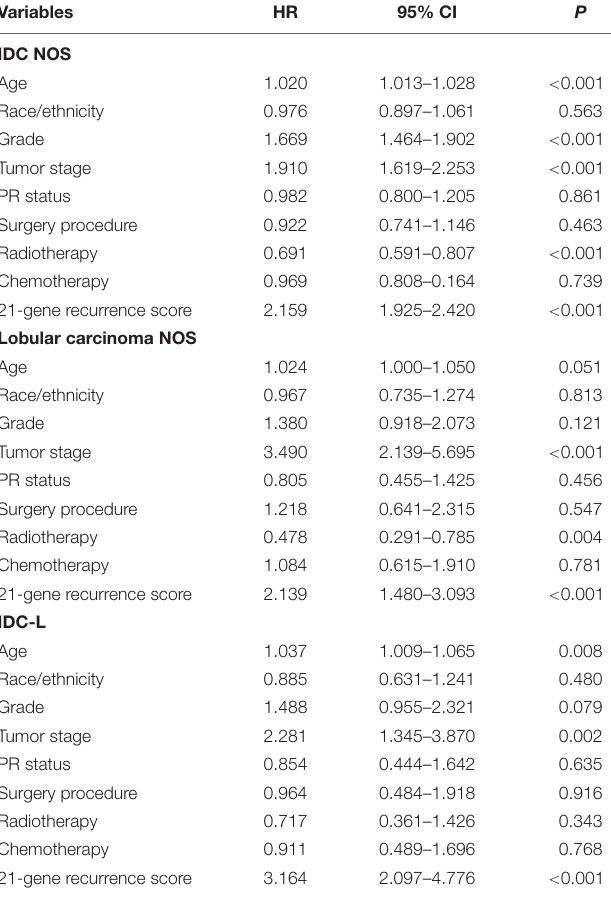
TABLE 2 | Multivariate analysis for prognostic factors of breast cancer-specific survival by histologic